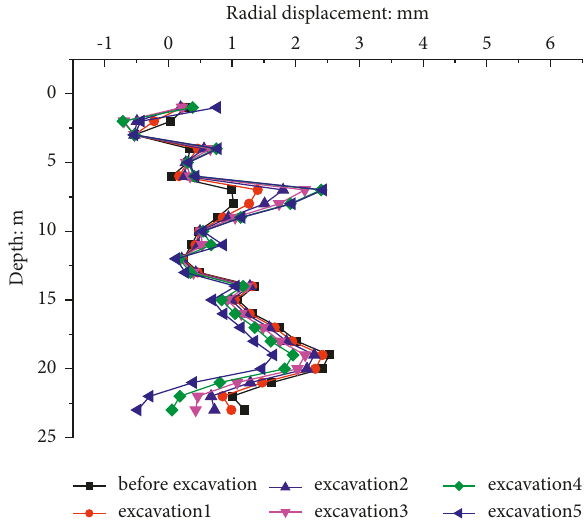
Figure 32: The horizontal displacement of # 2 measuring point changes with depth.